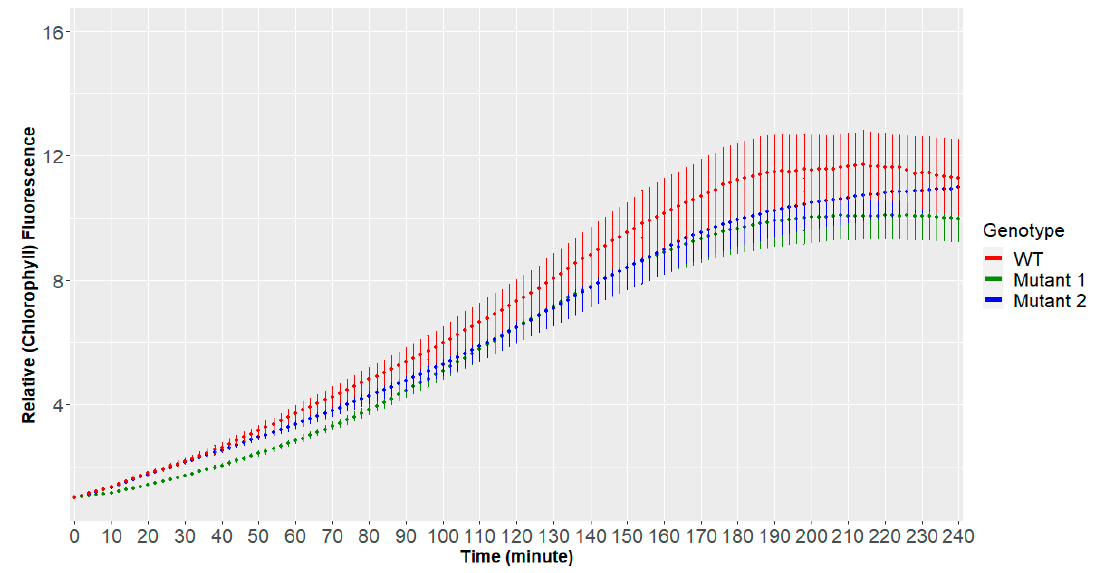
Figure 1. Means (dots) and confidence intervals (error bars) for groups of time series (WT: wild type).